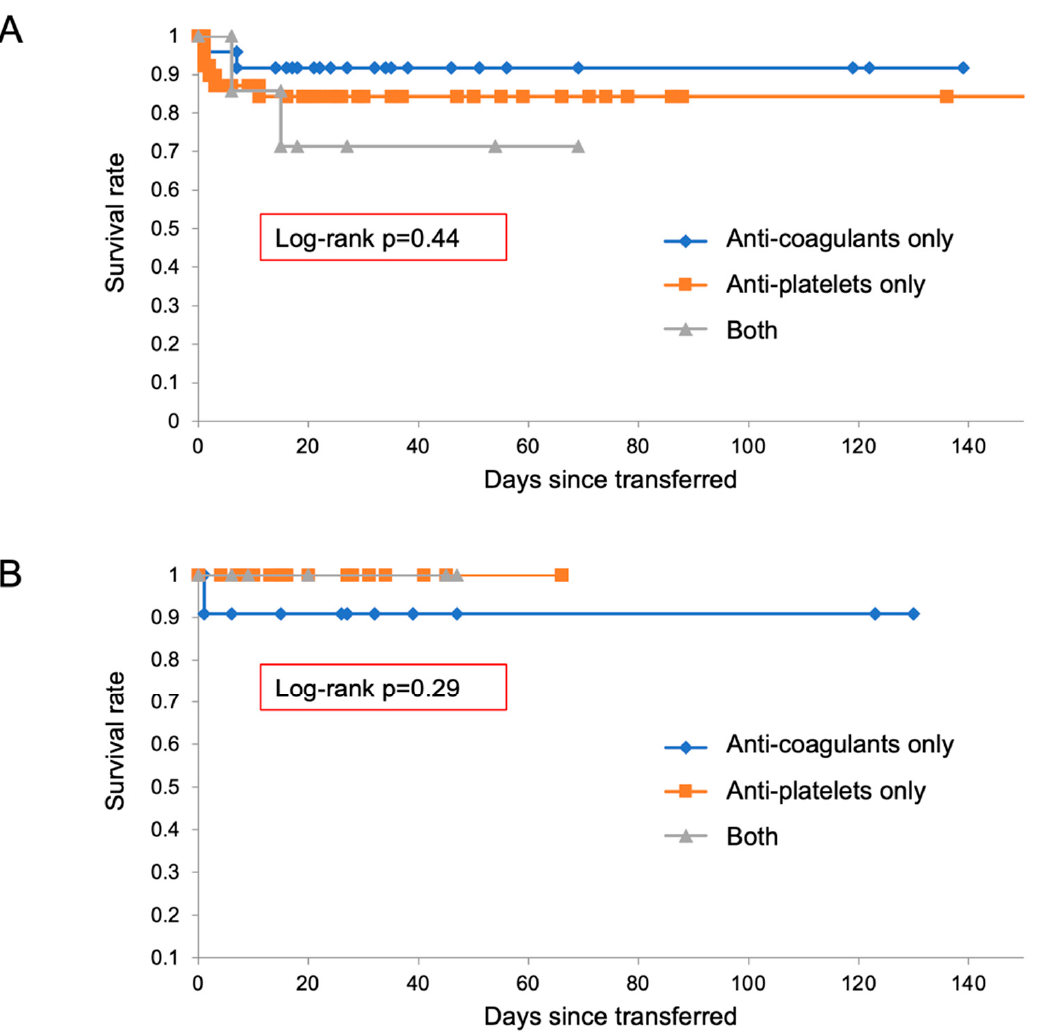
Figure 3. Kaplan–Meier curves of transferred patients receiving “anti-coagulants”, “anti-platelet drugs”, and “both of them”, in type A (panel ( A )) and type B (panel ( B )). In type B, 38 patients were treated by anti-thrombotic drugs on admission, including 11 with anti-coagulants, 22 with anti-platelet drugs, and 5 with both. This group had significantly higher prevalence of previous history of atrial fibrillation, coronary artery disease, dyslipidemia, aortic valve replacement, and coronary artery bypass graft, as well as RAAS inhibitor use (Figure 1, Tables 1–3). Among them, one patient (2.6%) died during hospitalization. Of the remaining 193 patients with type B who were not treated with anti-thrombotic drugs, 14 patients (7.3%) died during hospitalization. The Kaplan–Meier curve reveals the comparable prognosis between the two type-B groups (Figure